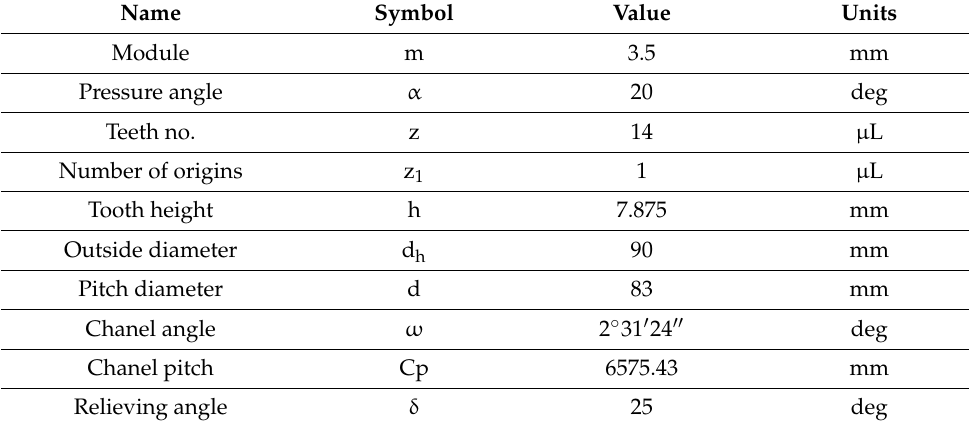
Table 1. The hob